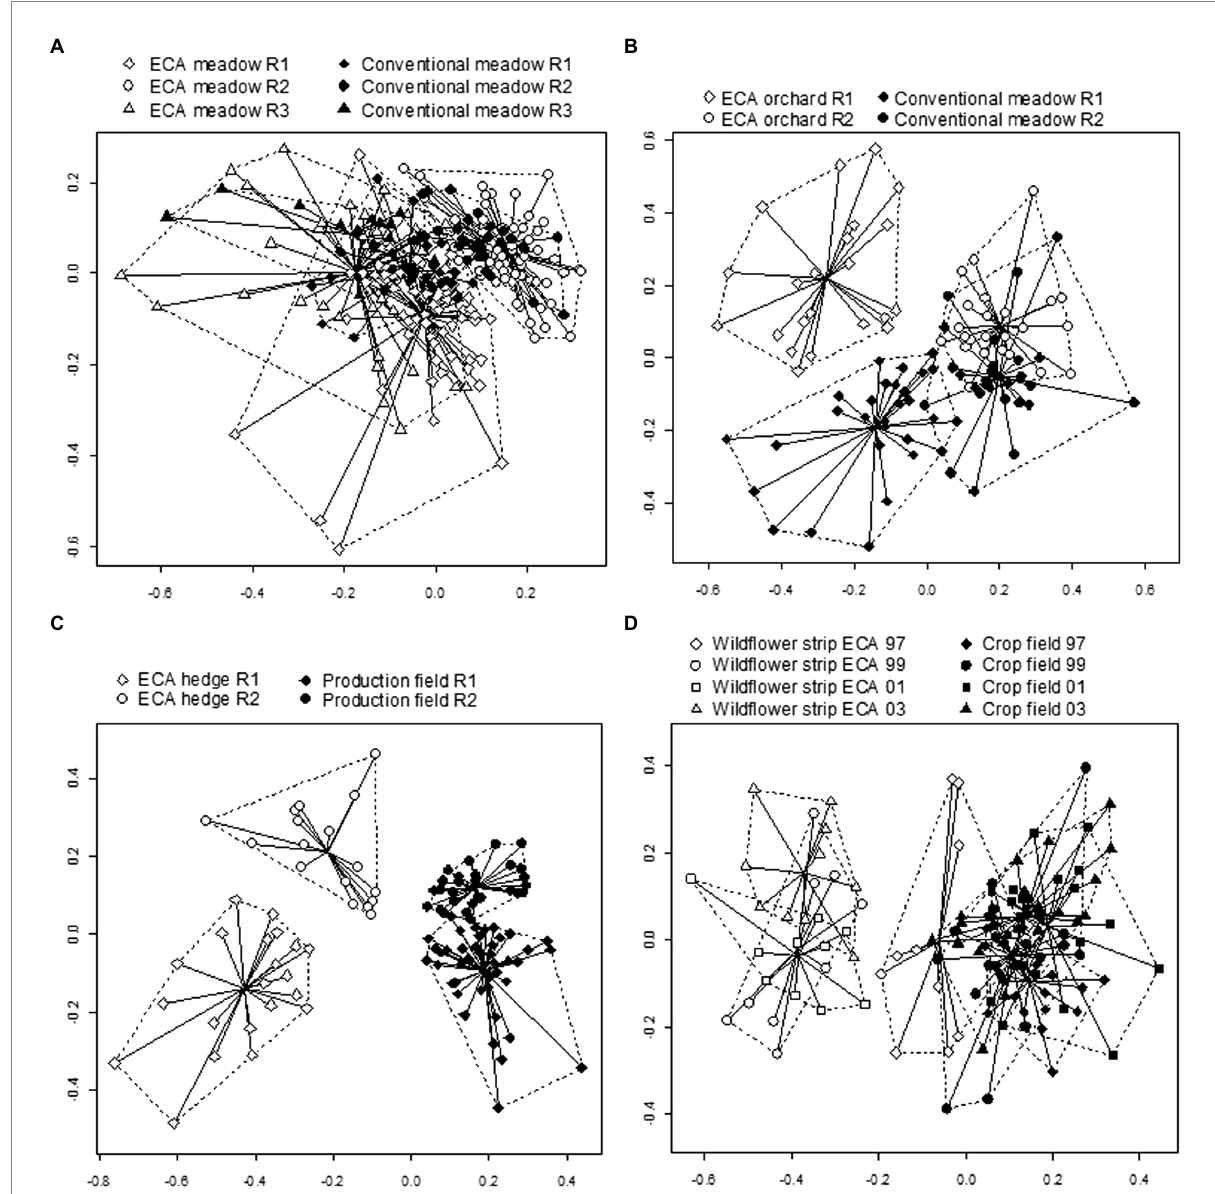
FIGURE 2 Non-metric MDS plots showing the pattern of dissimilarities and distance to centroid (using the Gower dissimilarity measure, excluding double zeros) with log10 + 1 transformed data among spider assemblages in BPA and conventionally managed fields. Habitat types are compared by pairs, i.e., (A) BPA vs. conventional meadow, (B) BPA orchard vs. conventional meadow, (C) BPA hedge vs. production field (encompasses crop fields and conventional meadows), (D) wildflower strip BPA vs. crop field. R1 = region one, R2 = region two, R3 = region three. Centroids, hull envelope and multivariate dispersion (distance between each site and the centroid to which it belongs) are shown for groups combining each habitat type per region. The comparison of wildflower strip BPA vs. crop field occurs in region three only for which centroids, hull envelope and multivariate dispersion combine habitat type and sampling year (1997, 1999, 2001,